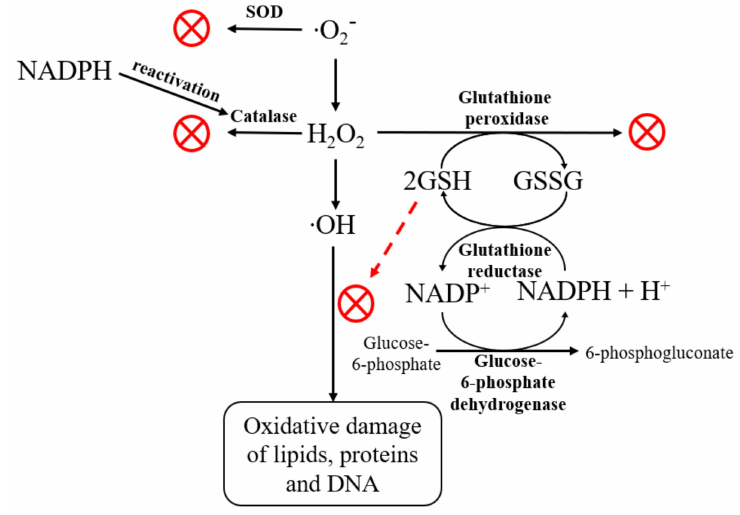
Figure 9. Effects of NADPH and glutathione on the cellular antioxidation capacity due to H 2 O 2 and · OH elimination.